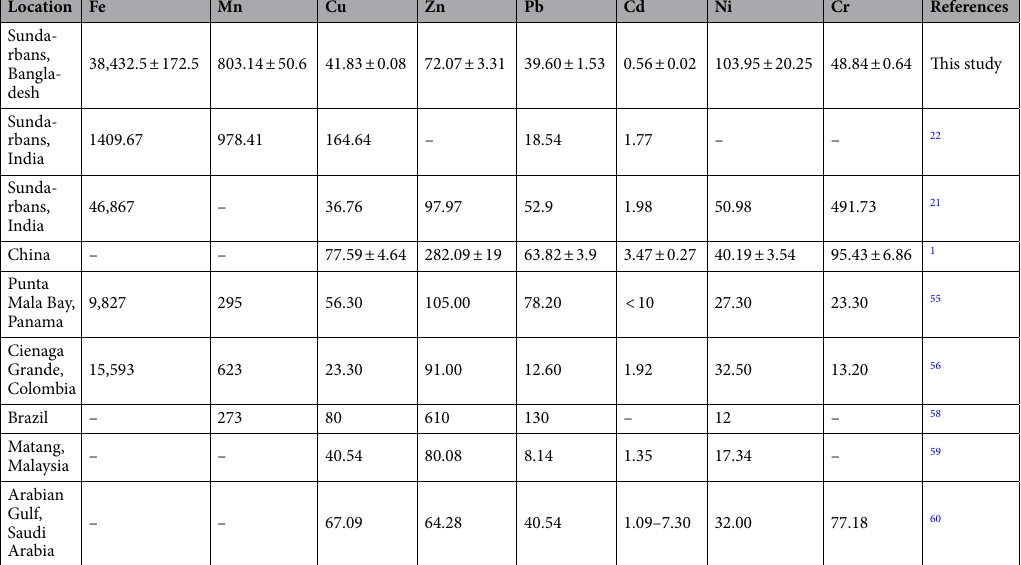
Table 5. Comparison of trace metals concentrations (µg g −1 ) in worldwide mangrove soils.